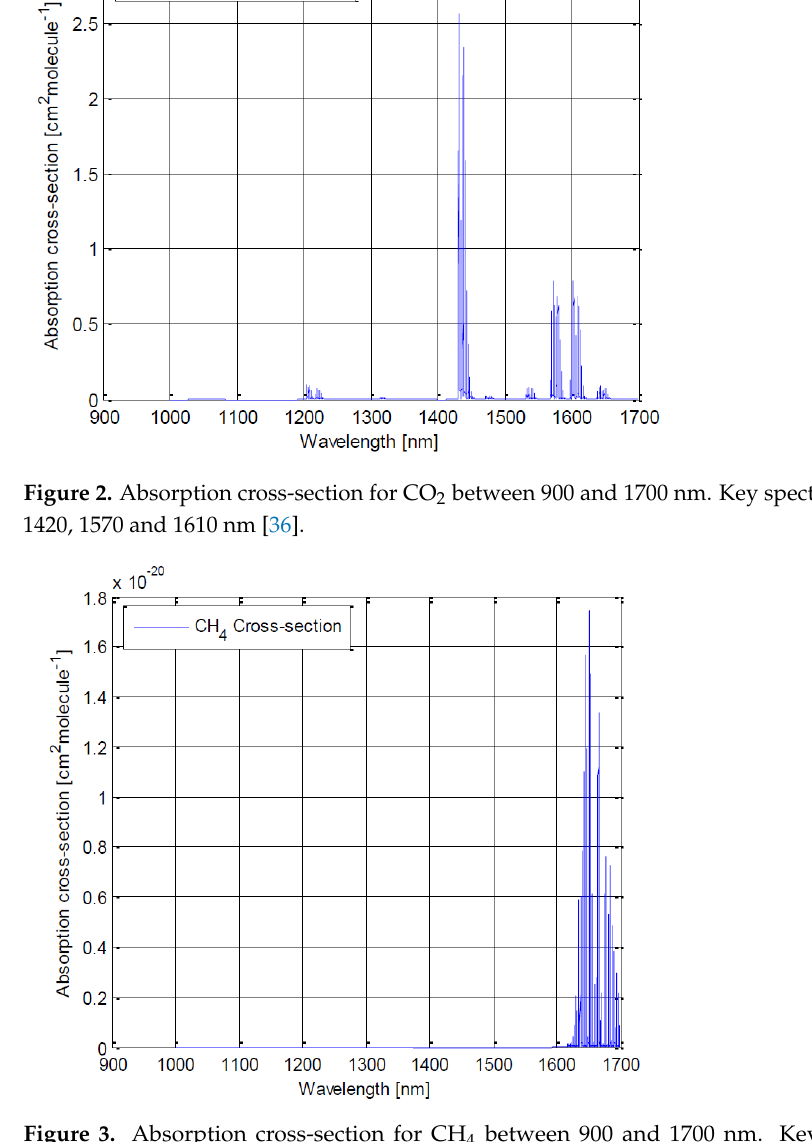
Figure 3. Absorption cross-section for CH 4 between 900 and 1700 nm. Key spectral line is at 1670 nm